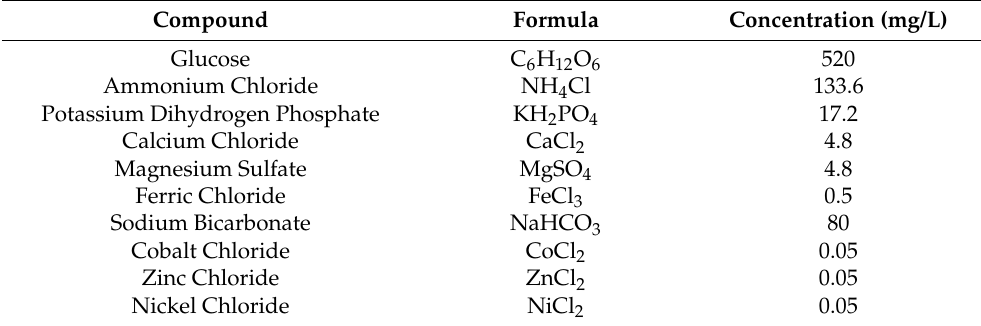
Table 2. Synthetic wastewater